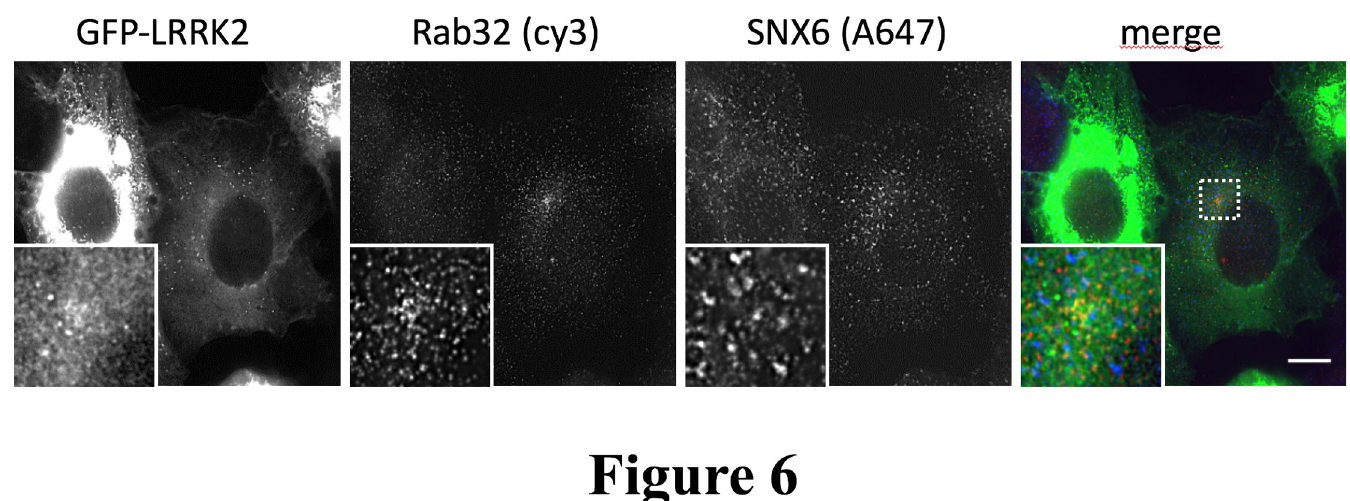
Fig 6. Co-localization analysis of GFP-LRRK2 with endogenous Rab32 and SNX6. SH-SY-5Y stably expressing GFP-LRRK2 cells were cultured on glass cover slips for 48 hours. Then, cells were stained with antibodies against Rab32 and SNX6. Secondary antibodies were coupled to cy3 or Alexa 647. Cells were analyzed wit a Zeiss SIM microscope. n = 2 independent experiments. Colors in the merge image: GFP = green, cy3 = red, Alexa 647 = blue color; Scale bar = 10 μ m.